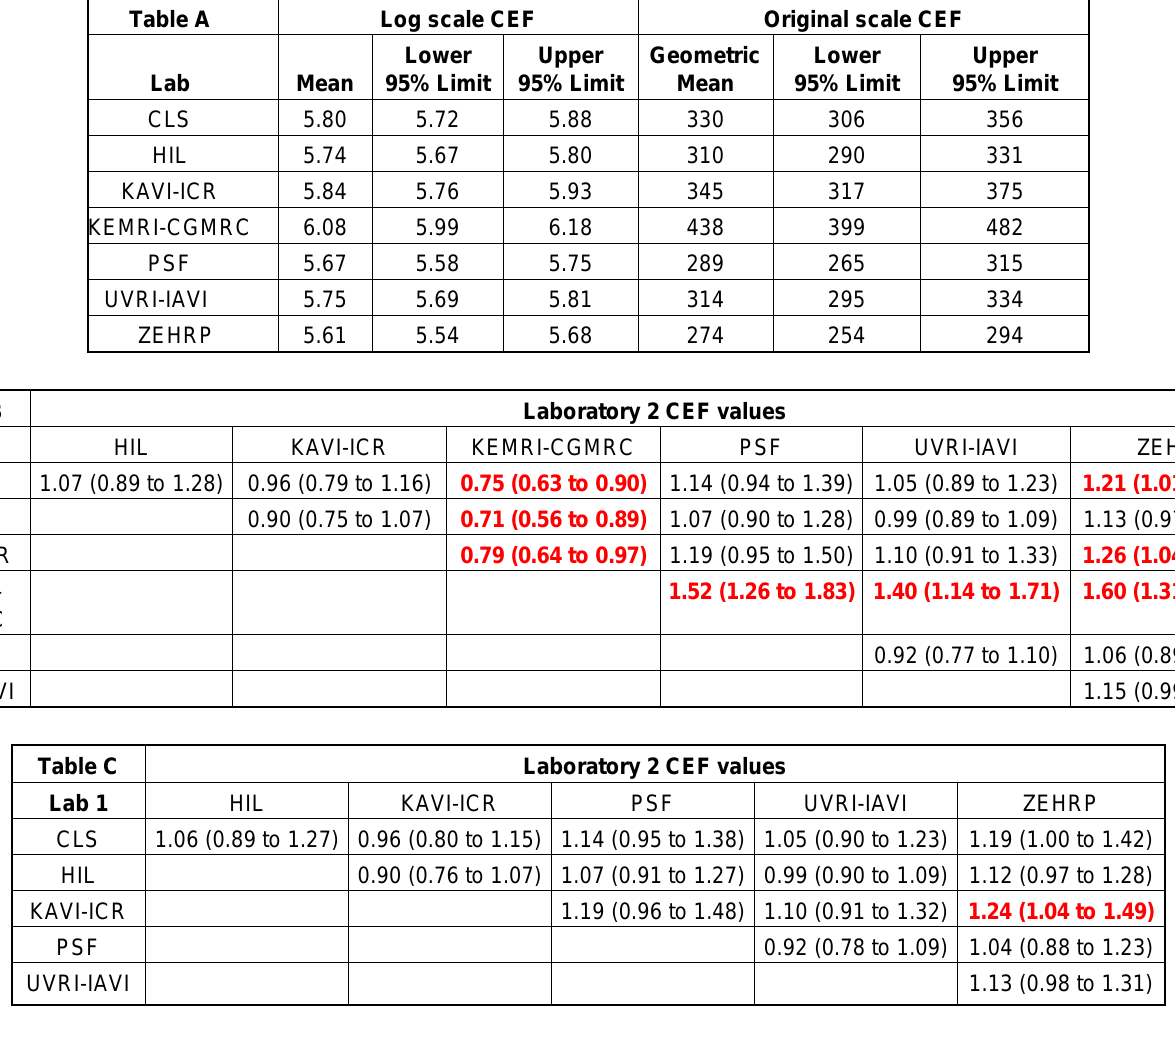
TABLE 2A, B, C-S1: Least squares mean CEF counts and differences between laboratories. S2A Table: CEF. Least squares parameter estimates and 95% confidence intervals (Bonferroni adjusted) from a repeated measures Poisson regression model of spot count on subject, site and month . S2B Table: Pairwise comparisons between sites, adjusted (Bonferroni) for multiple comparisons, from the same regression model as S2A Table above. Each cell shows the difference in least squares mean log count (Lab 1 - Lab 2) with 95% confidence intervals, exponentiated to the original scale (Overall p-values from regression model: Site = 0.0045, Month = 0.41). S2C Table : Pairwise comparisons between sites, adjusted (Bonferroni) for multiple comparisons, from the same regression model as S2A Table but excluding Kilifi: the overall differences between laboratories are not significant (p-values: Site = 0.11, Month =